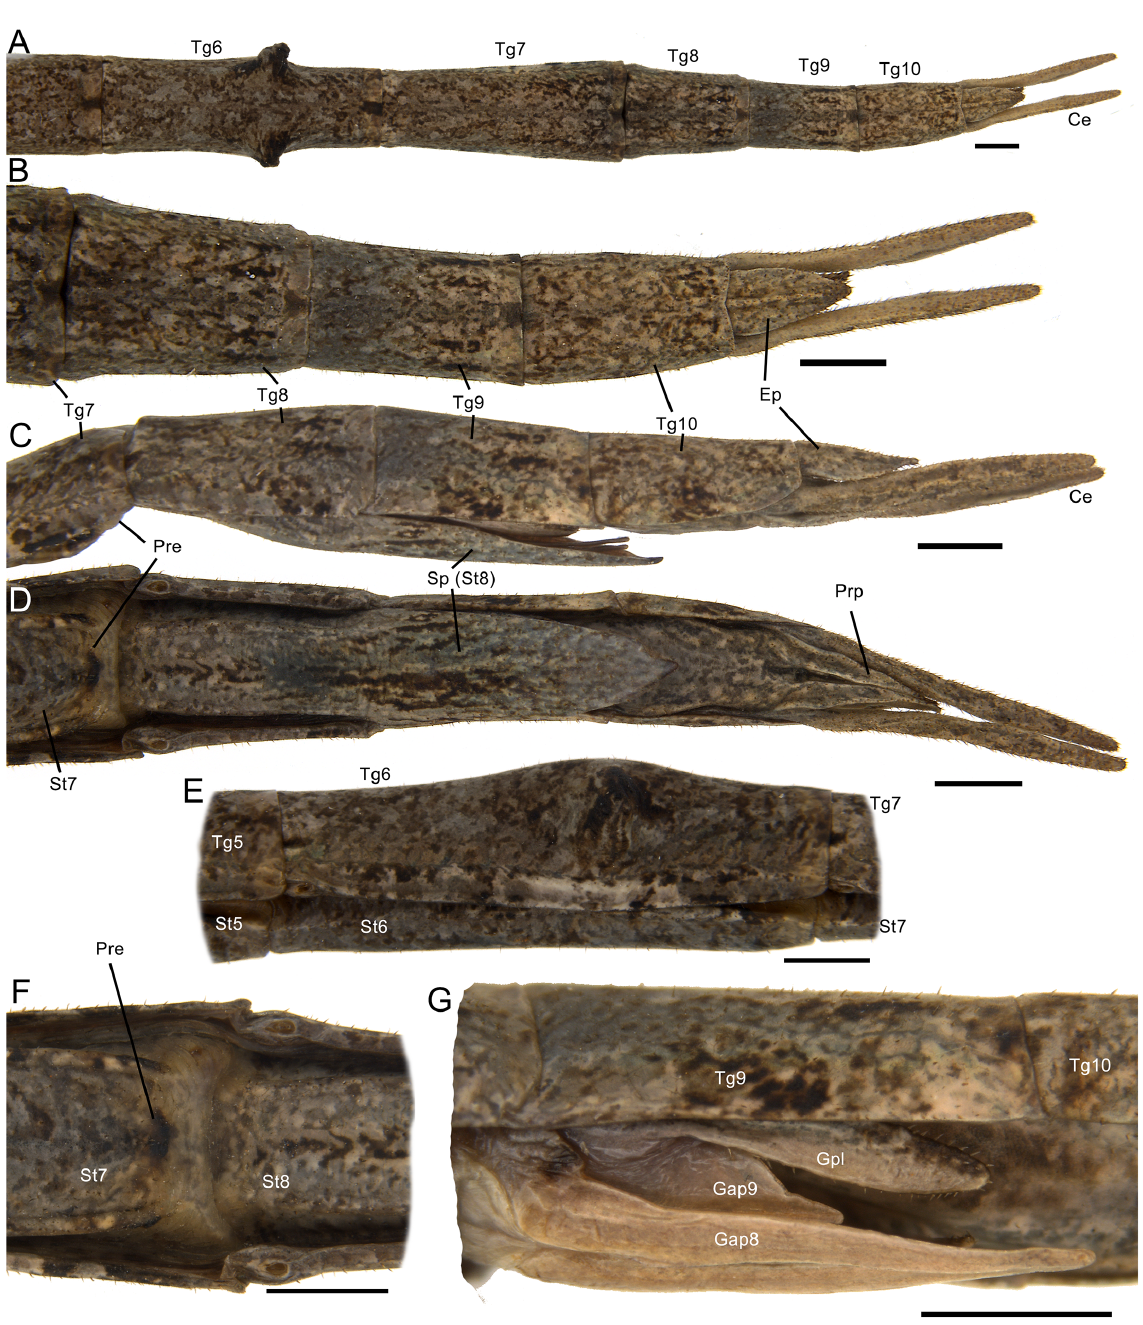
Fig. 50. Arumatia diamante Ghirotto gen. et sp. nov., holotype, ♀ (MZUSP V0650), terminalia morphology. A . Dorsal view. B . Detail of dorsal view. C . Lateral view. D . Ventral view. E . Sixth segment in lateral view showing a tubercle. F . Detail of praeopercular organ, ventral view. G . Detail of external genitalia, lateral view. Abbreviations: Ce = cercus; Ep = epiproct; Gap = gonapophysis; Gpl = gonoplac; Pre = praeopercular organ; Prp = paraproct; Sp = subgenital plate; St = sternum; Tg = tergum. Scale bars: 1